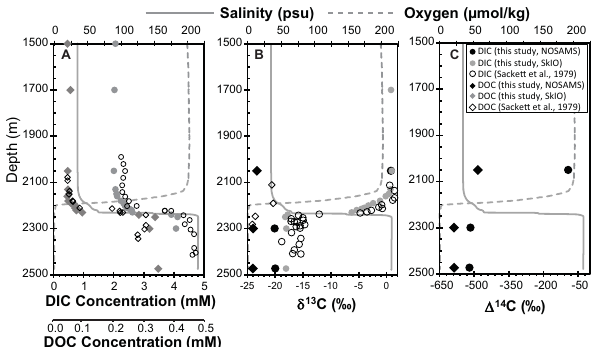
Fig. 1. Depth profiles of salinity (gray solid line) and dissolved oxy- gen concentrations (gray dashed line) are plotted for the south basin of Orca Basin brine along with (A) concentrations of DIC (filled circles, this study; open circles from Sackett et al., 1979) and DOC (filled diamonds, this study; open diamonds from Sackett et al., 1979); (B) δ 13 C values of DIC and DOC; and (C) 1 14 C values for DIC and DOC. Error bars are smaller than symbols for this study ( ± 0.04–0.5‰ for δ 13 C values and ± 1–3‰ for 1 14 C